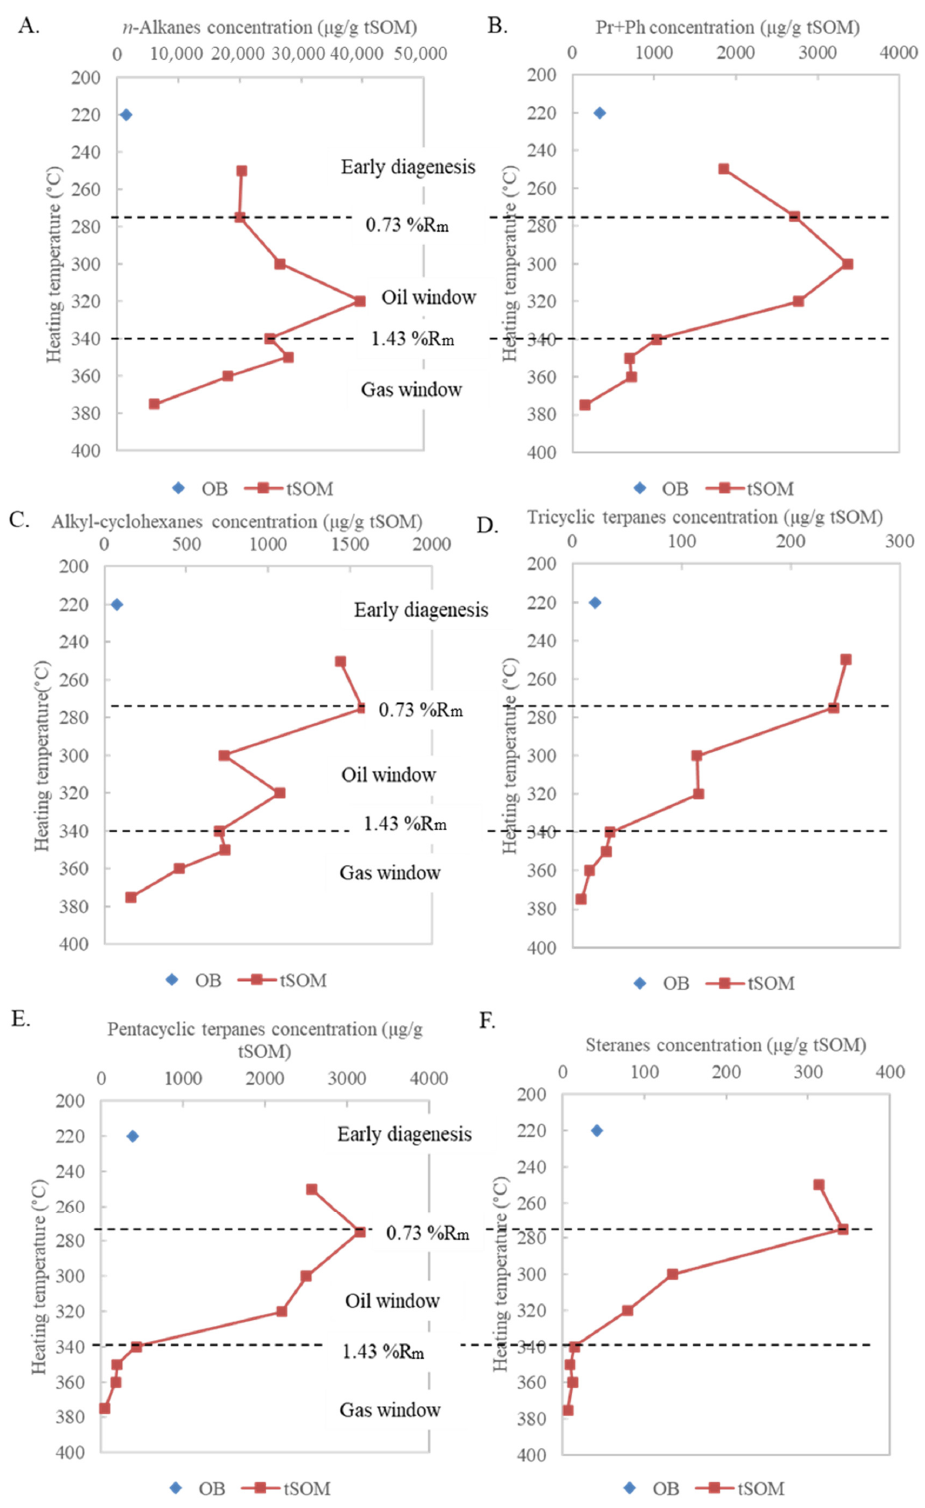
Figure 3. Changes in the concentrations of different saturated hydrocarbon compound classes in the OB and in the tSOMs (own elaboration),. Each data dot on subfigure ( A – F ) represents the concentration of the compound class generated either in the original bitumen (OB) or in the total soluble organic material (tSOM) under different heating target temperatures. Note: The OB was assigned a heating temperature of 220 ◦ C for visualization purpose only. See Table 1 for the formula of the summed concentration of each compound